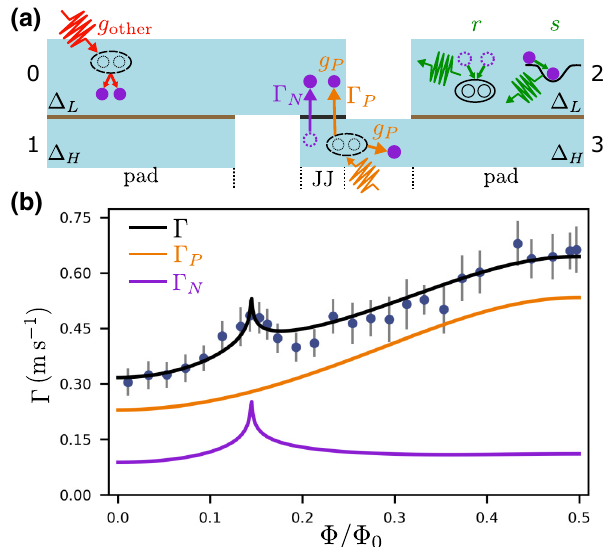
FIG. 3. (a) An illustration of the QP processes included in our model. The films are numbered 0–3 for reference in the text. The generation of QPs may occur by pair breaking in the pads (red) at rate g other or by PAPS at the JJ (orange) at rate g P . QPs tun- nel across the JJ at rates (cid:4) P (orange) and (cid:4) N (purple). QPs are eliminated by recombination at rate r or are removed from the tunneling population by trapping at rate s in each film (green). (b) The parity-switching rate (cid:4)((cid:5)) from (cid:5)/(cid:5) 0 = 0 to (cid:5)/(cid:5) 0 = 0.5. The fit to the self-consistent model (Sec. IV A) is indicated in black, with the (cid:4) N (purple) and (cid:4) P (orange) contributions shown explicitly. The peak near (cid:5)/(cid:5) 0 ≈ 0.145 is explained by the δ(cid:2) ≈ hf q condition illustrated in Fig.